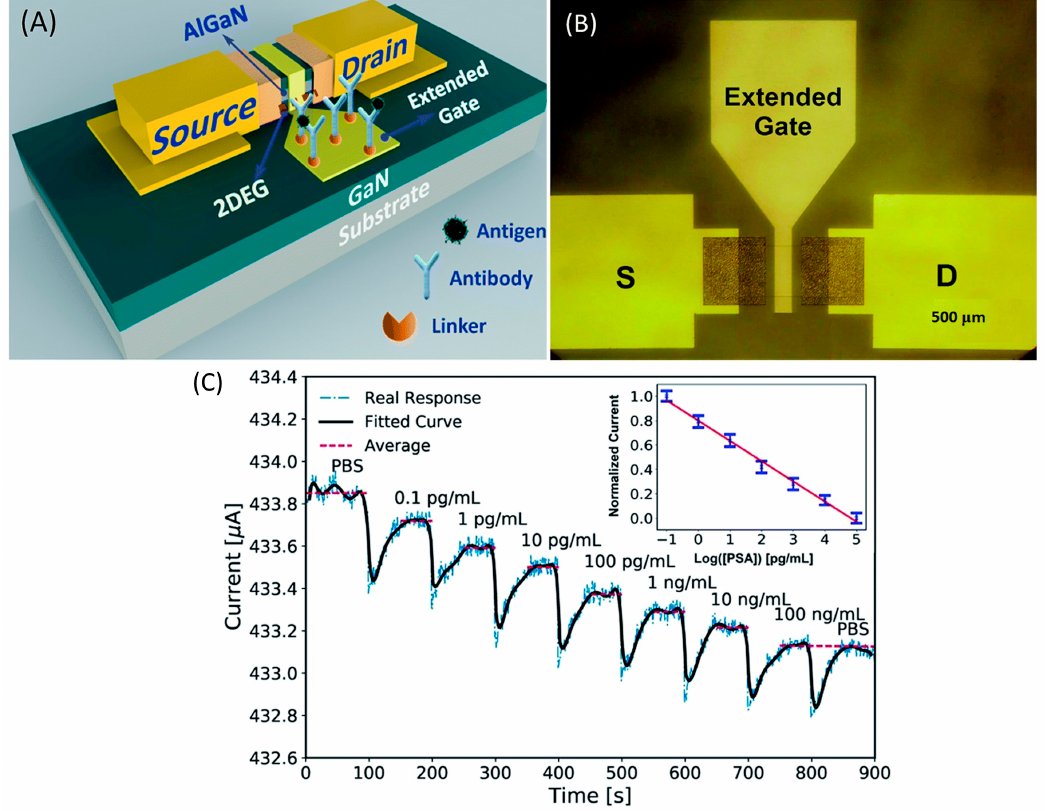
Figure 5. The structure of the EG-AlGaN/GaN HEMT: ( A ) a schematic illustration of the device, and ( B ) a plan view photomicrograph. ( C ) The real-time detection of PSA (the bold black line is a fitted curve and the red dashed lines are the average values). Reprinted with permission from [126]. Cop- yright 2017, RSC Advances.